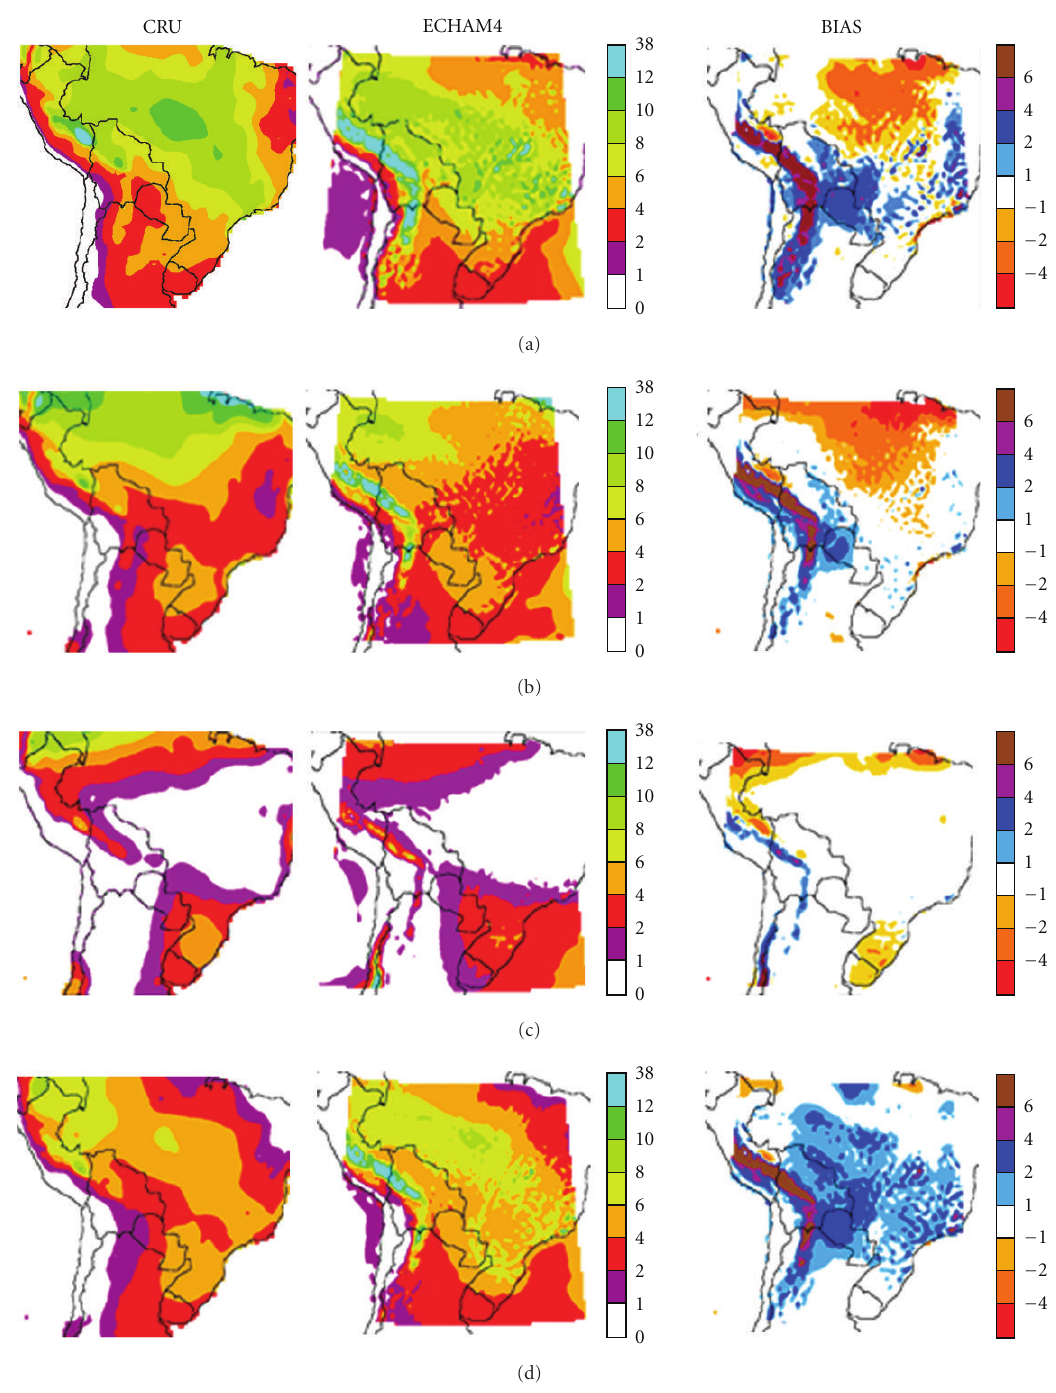
Figure 4: CRU fields (left column) and CONTROL-EC4 (center column) seasonal precipitation, given as precipitation rate (mmday − 1 ) for (a) summer (DJF), (b) autumn (MAM), (c) winter (JJA) and (d) spring (SON). The bias, that is, CONTROL-EC4 minus CRU, is shown in the right